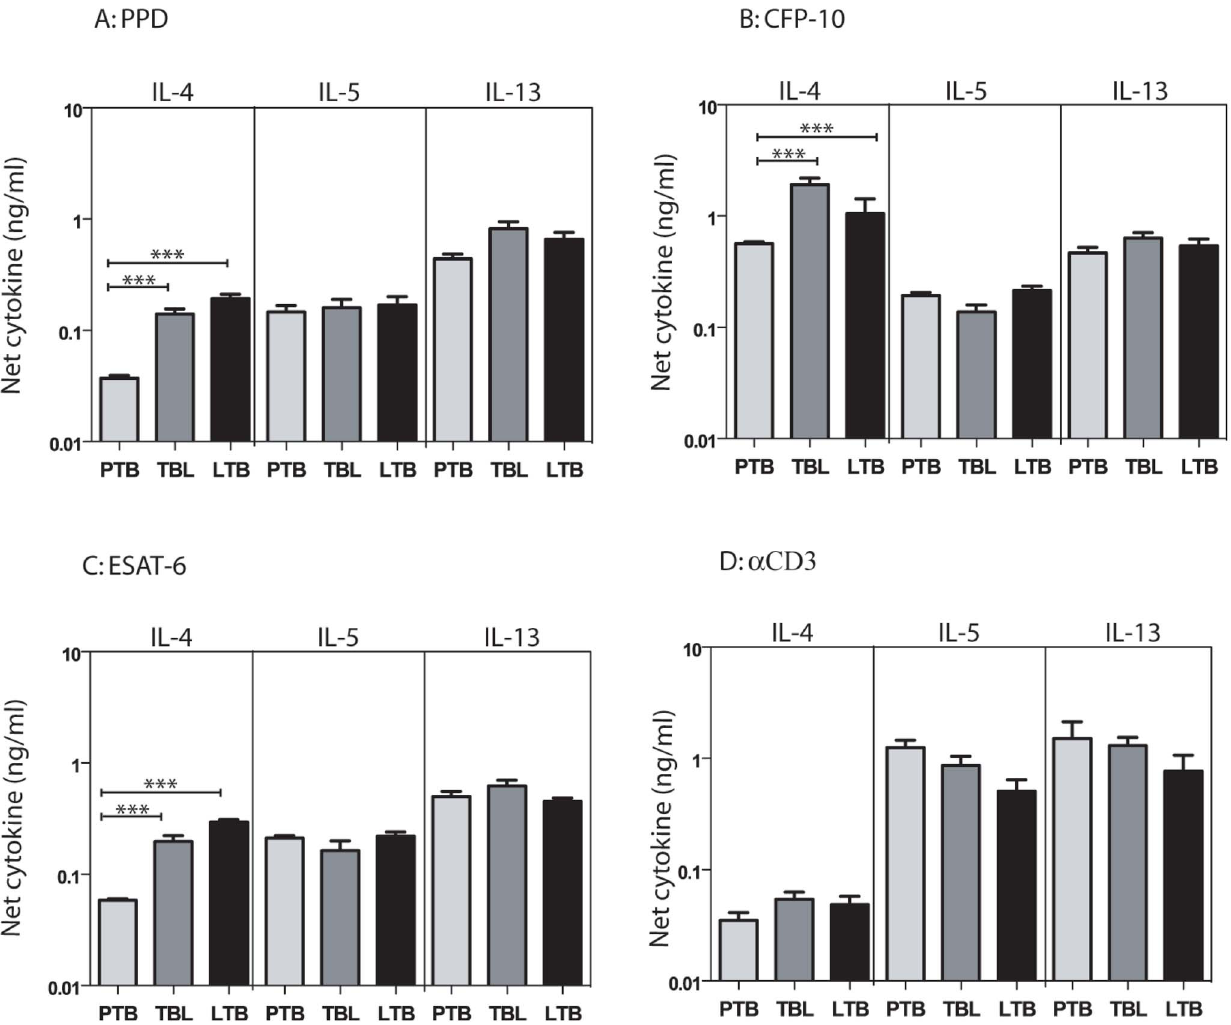
Figure 3. PTB is associated with decreased antigen-stimulated production of IL-4. Whole blood from PTB, TBL and LTB individuals was stimulated with (A) PPD (10 m g/ml) or (B) ESAT-6 (10 m g/ml) or (C) CFP-10 (10 m g/ml) or (D) anti-CD3 (5 m g/ml) for 72 h, and levels of Type 2 cytokines IL-4, IL-5 and IL-13 were measured by ELISA. Results are shown as net cytokine production over media control. The bars represent geometric means and 95% confidence intervals. P values were calculated using the Kruskal-Wallis test with Dunn’s multiple comparisons comparisons (* p , 0.05, ** p , 0.01, *** p , 0.001).